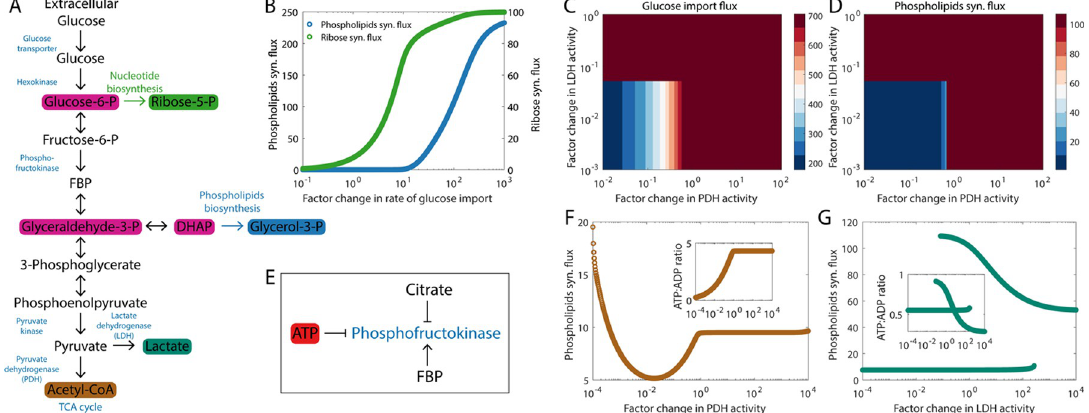
Fig 1. High ATP production during oxidative phosphorylation can drive a preference for aerobic glycolysis in fast proliferating cells. (A) Reactions in the glycolytic pathway and key anabolic processes that use glycolytic intermediates as substrates. The pyruvate generated at the end of glycolysis can either be excreted out as lactate or enter the TCA cycle as acetyl-CoA. (B) Increased glucose uptake can drive large fluxes through the ribose synthesis pathway and through the phospholipids synthesis pathway. (C) Increasing the activity of pyruvate dehydrogenase (PDH), lactate dehydrogenase (LDH), or both can increase the glucose uptake. (D) The phospholipids synthesis flux increases upon the upregulation of PDH, LDH, or both. In (C) and (D), we have assumed that the ATP concentration in the cytoplasm remains constant despite the higher ATP production per glucose molecule when glucose is allowed to enter the TCA cycle by upregulating PDH activity. (E) Different metabolites that can modulate the enzymatic activity of phosphofructokinase (PFK). FBP: fructose- 1, 6 -biphosphate. (F) Variation of the phospholipids synthesis flux with an increase in PDH activity (while keeping LDH activity fixed). (G) Variation of the phospholipids synthesis flux with an increase in LDH activity (while keeping PDH activity fixed). The insets in (F) and (G) show how the ATP:ADP ratio varies in each case. The bistability in the phospholipids synthesis flux as the LDH activity is varied arises from a positive feedback loop—fructose-1, 6-biphosphate, the product of PFK’s enzymatic activity, can allosterically activate the enzyme (see panel E). In panels C and D, the bistability shows up as a very sharp change in the fluxes with increasing LDH activity. Fluxes are in units of mM h -1 (millimolar per hour) and are shown at steady state.